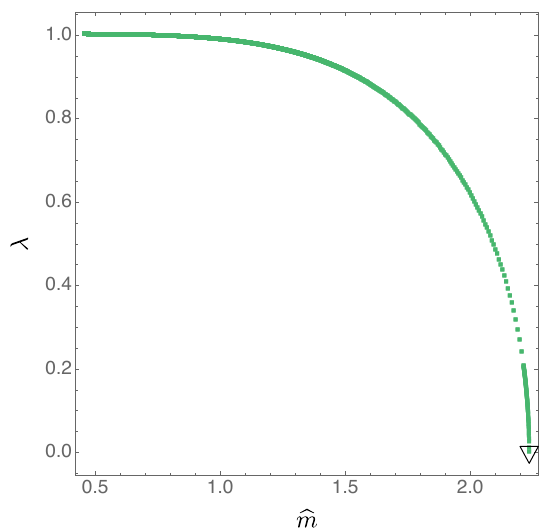
Figure 8 . The dimensionless quantity (cid:21) , de(cid:12)ned in (2.16), as a function of approach (cid:21) ! 1 from below as satisfy (cid:21) (cid:20) 1.